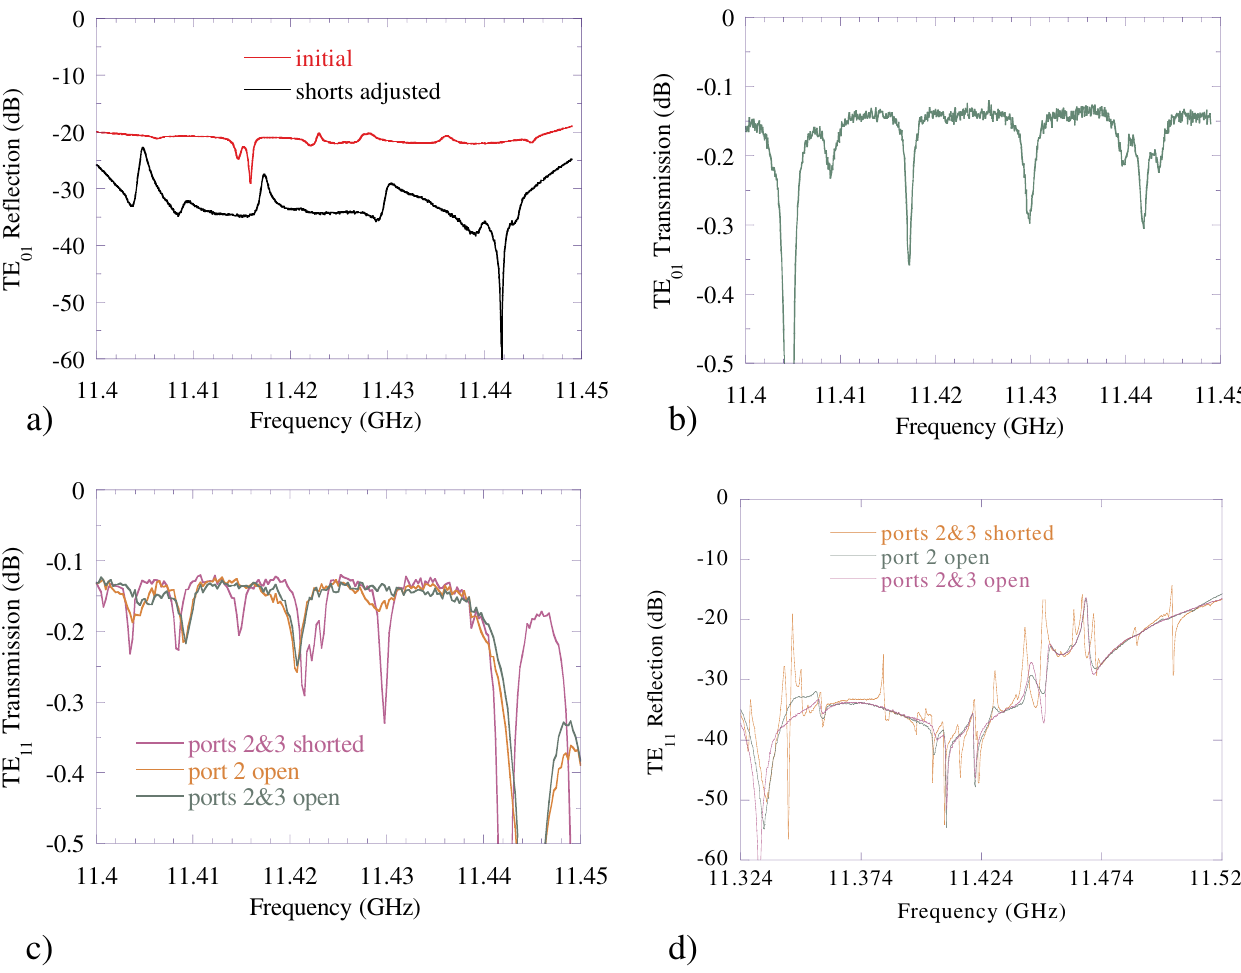
FIG. 11. (Color) Superhybrid cold tests. (a) Reflection measurements ( S ) for the circular TE mode from port 1 while shorting both 11 01 port 2 and port 3 and matching port 4. A 0.022 in. adjustment of the relative short positions significantly improved the match. mode transmission between port 1 and port 4 ( S ) while shorting both port 2 and port 3 (shifted up 0.09 dB to (b) Circular TE 01 41 mode transmission between port 1 and port 4 ( S ) for different conditions at account for loss of mode launchers). (c) Circular TE 11 41 mode reflection ( S ) for different conditions at port 2 and port port 2 and port 3. (d) Circular TE 11 11